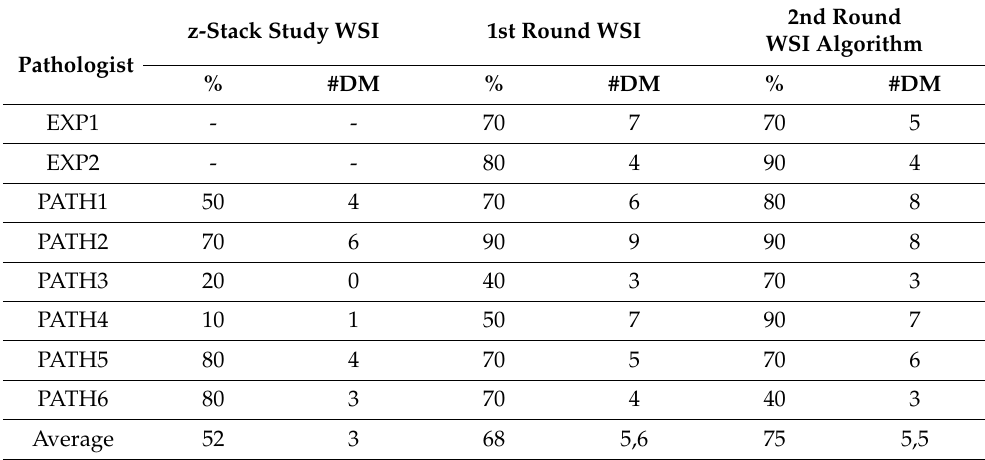
Table 3. Concordance of nevoid melanoma ( n = 10) as a percentage (%) of cases identical with the consensus diagnosis based on glass slides and number of cases with reported dermal mitosis (#DM).